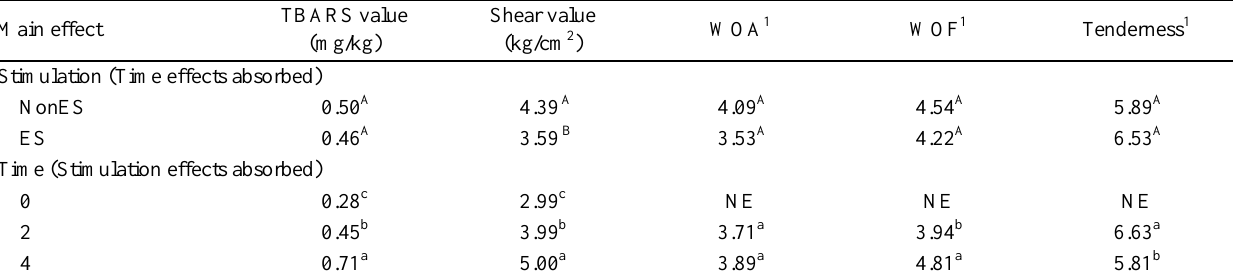
Table 3. Main effect of electrical stimulation or time on TBARS values, shear values, WOA, WOF and tenderness of precooked roast